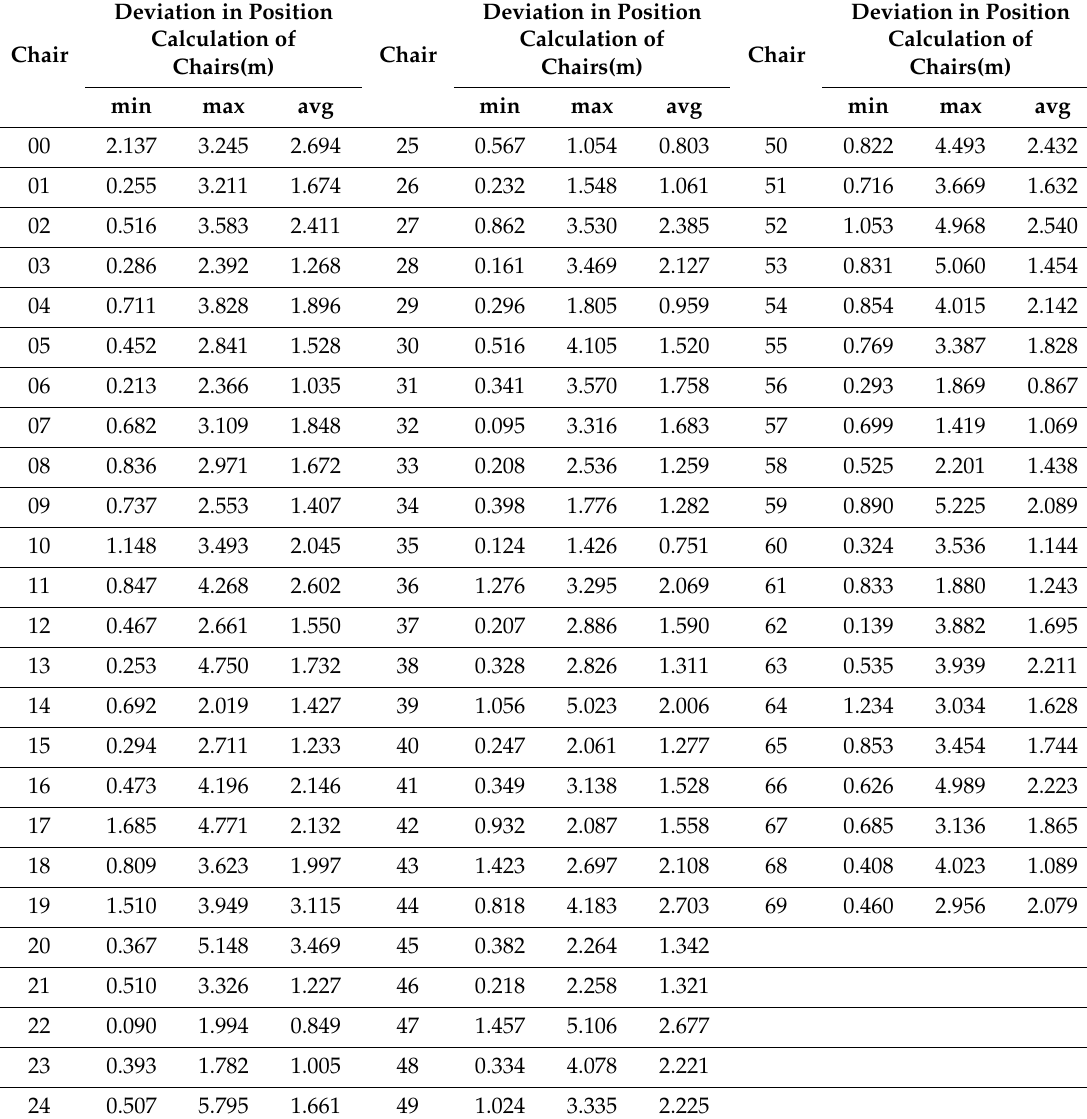
Table 2. Deviation in position calculations of chairs in the room type